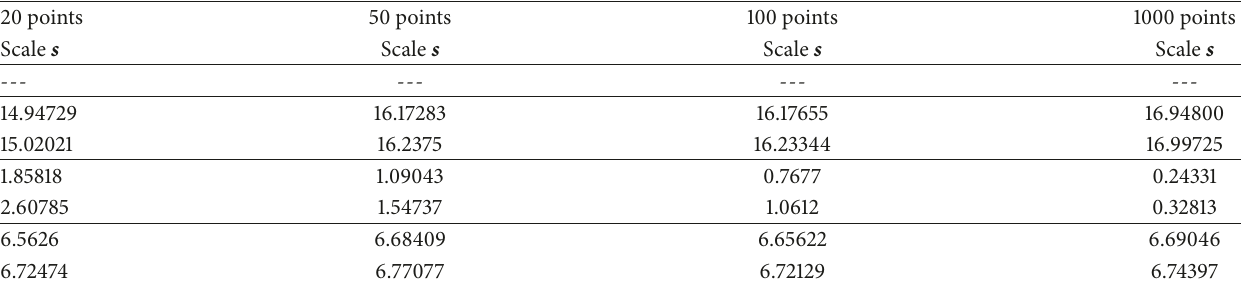
Table 19: Log-normal distributions with 50% noise level.